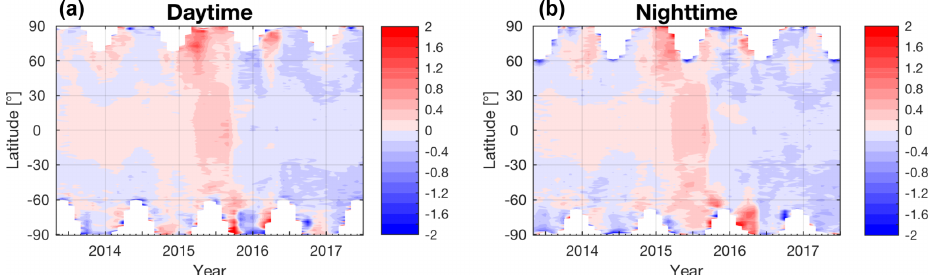
Figure 3. Contour representation of the relative difference (in percent) between IASI-A and IASI-B total ozone column (TOC) products for the 1 ◦ zonal monthly mean TOCs for the period from May 2013 to July 2017 for daytime data (a) and nighttime data (b) . The relative differences are calculated as 100 × (IASI-A − IASI-B) / IASI-A.